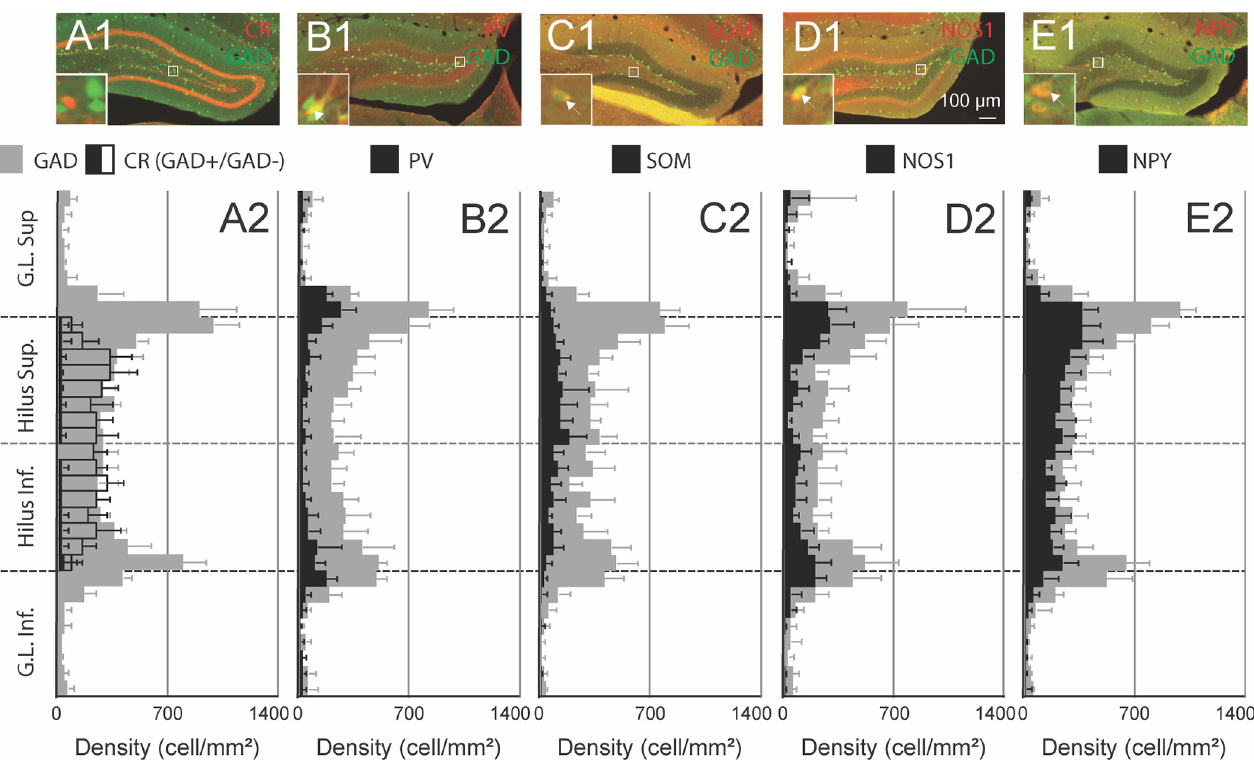
Fig 1. Immunoreactivity for classic GABAergic interneuron markers is observed within specific subregions of the dentate gyrus. A1-E1: CR, PV, SOM, NOS1 and NPY immunostaining in the dentate gyrus of a GAD67-GFP knock-in mouse, the delineated area is enlarged in the inset. A2-E2: Densities of GFP expressing cells (grey), and PV, SOM, NOS1 and NPY positive GFP expressing cells (black) in the outer blade of the granular cell layer (G.L. Sup: bin 1 to 8), upper half of the hilus (Hilus Sup.: bin 9 to 16), lower half of the hilus (Hilus Inf.: bin 17 to 24) and inner blade of the granular cell layer (G.L. Inf.: bin 25 to 32). In A1, the black outline represents the density of all GABAergic and non-GABAergic CR positive cell. CR positive cells were not counted in bin 0 to 7 and 24 to 31. PV and NOS1 expressing GABAergic interneurons accumulate near the border between the hilus and the granular cell layer, whereas SOM expressing cells are more concentrated in the hilus (n = 7 mice/marker, error bars: